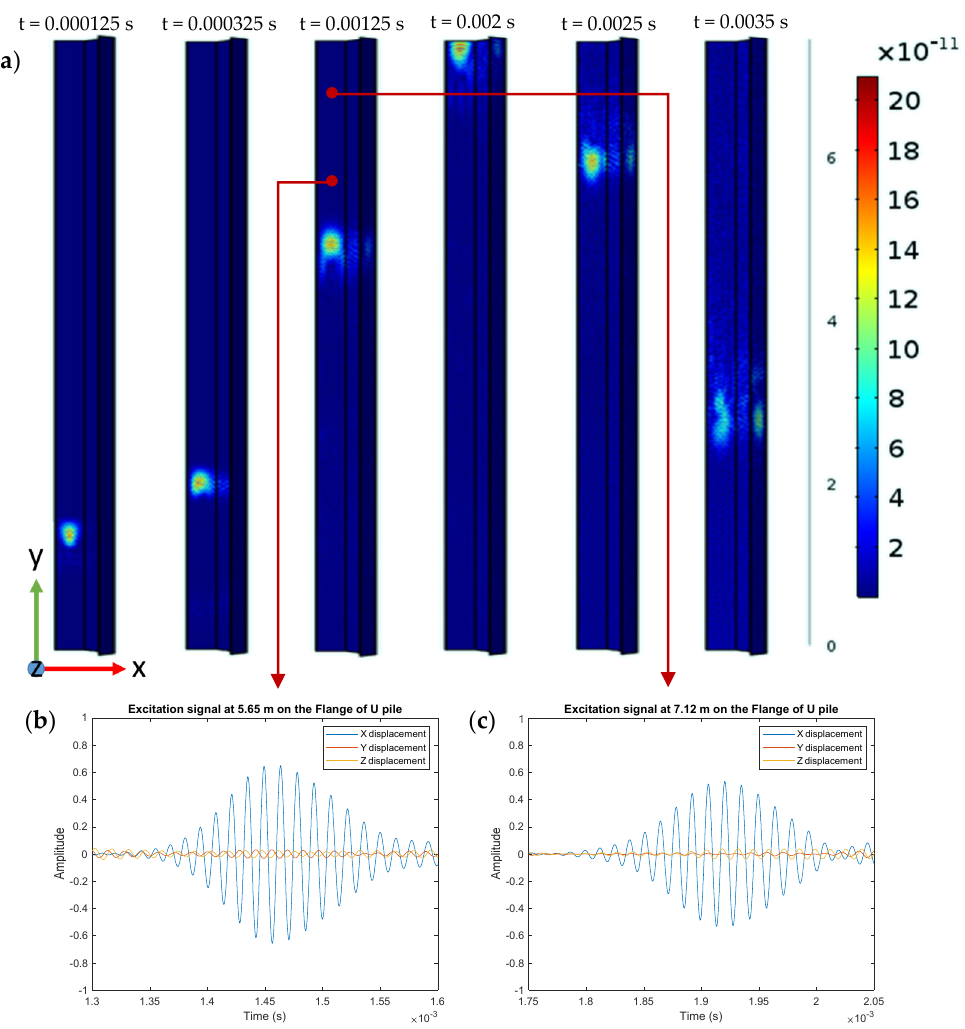
Figure 15. ( a ) Shear wave propagation in the flange of the U-pile, ( b , c ) the excitation signal when it reached the distances of 5.65 m and 7.12 m, respectively.